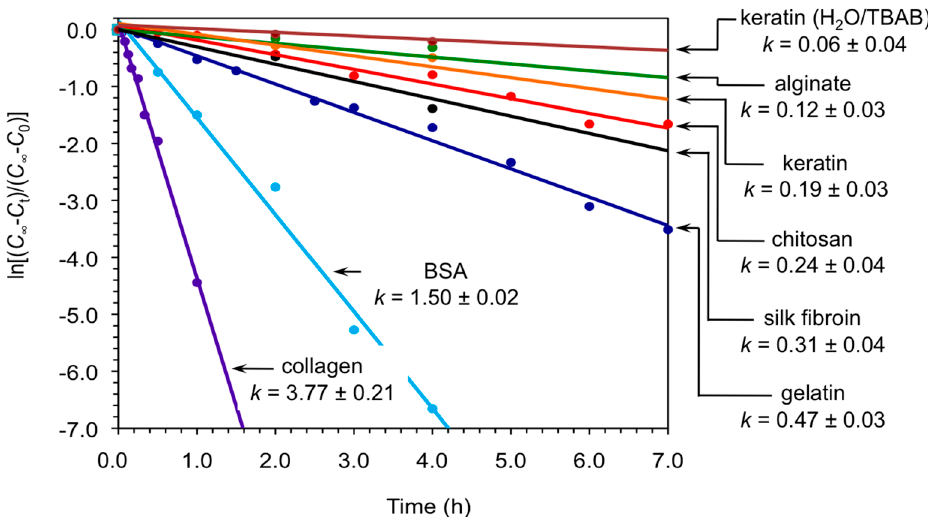
Figure 2. First-order kinetics plots for the nitroaldol (Henry) reaction between 1a and 2a catalyzed by different biopolymers in powder form. Unless otherwise indicated, reactions were made in DMSO as described in the text and experimental section. Apparent rate constants are given in units of h − 1 . Each data point represents the average of at least two independent measurements. C infi = final concentration, at infinite time; C t = concentration at given time t; C 0 = initial concentration at t = zero time.